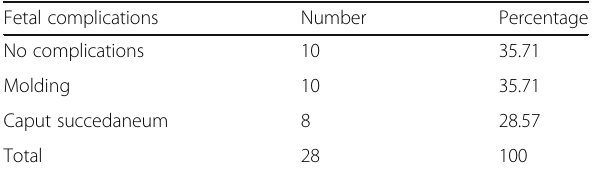
Table 3 Prediction of vaginal delivery by measuring FHPD